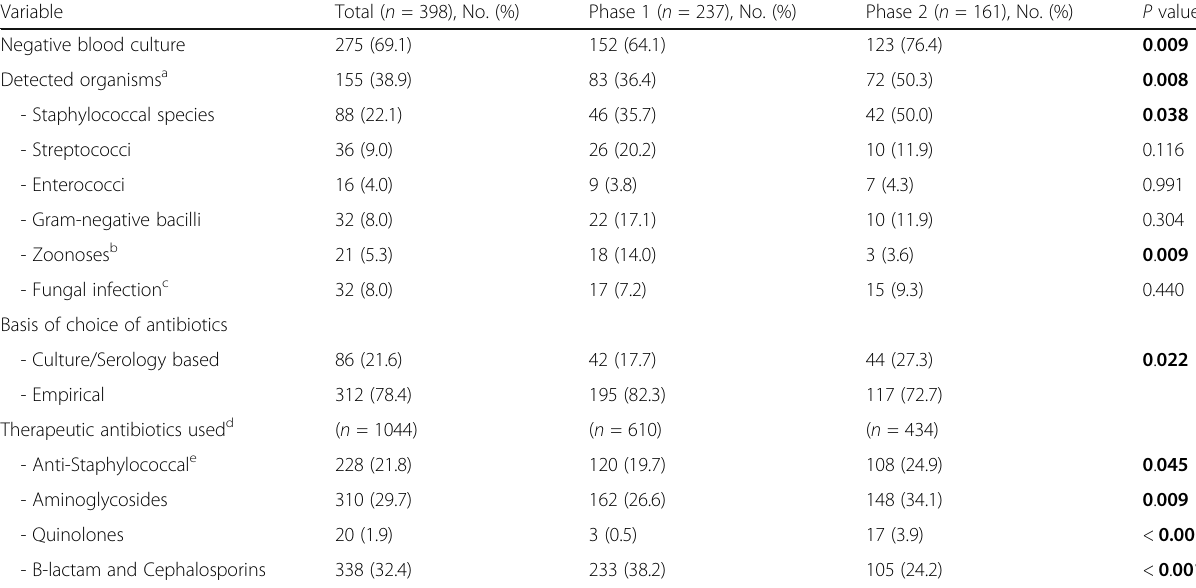
Table 3 Microbiological and antimicrobial data Variable Negative blood culture Detected organisms